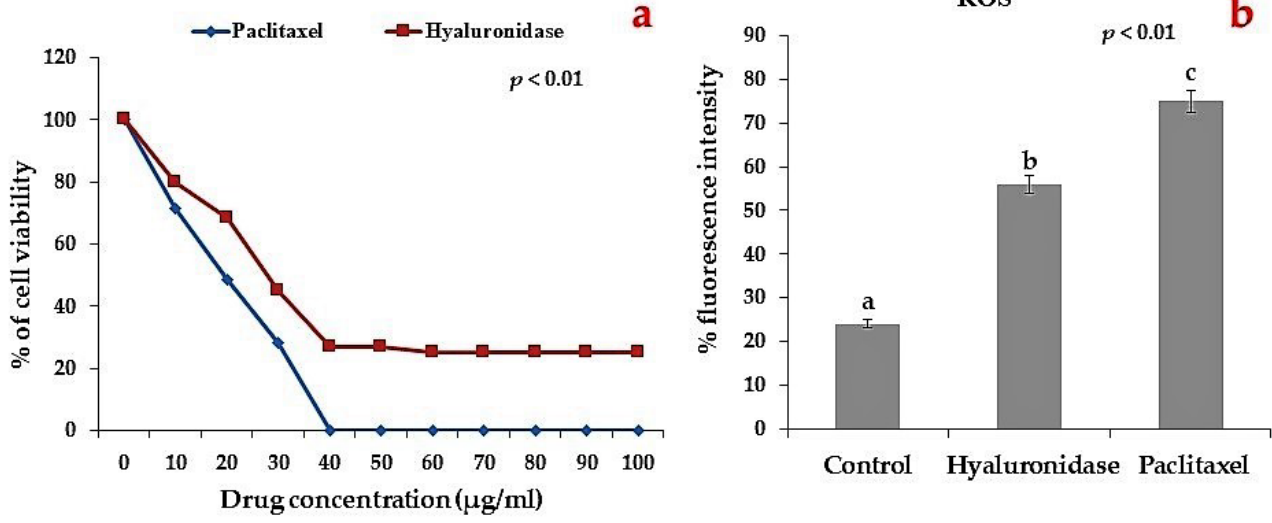
Figure 9. ( a ) Effect of Staphylococcal hyaluronidase on % of cell viability (24 h) in the control and enzyme-treated MCF-7 cells. IC 50 value was plotted by taking the enzyme concentration on x -axis versus percentage of cell viability on y -axis. Values are given as mean ± S.D. of six experiments in each group. Values not sharing a common marking differ significantly at p ≤ 0.05. ( b ) Effect of Staphylococcal hyaluronidase on ROS levels as measured By DCF fluorescence intensity using spectrofluorometer. Values are given as mean ± S.D. of six experiments in each group. Values not sharing a common marking (a, b, c) differ significantly at p ≤ 0.05 .